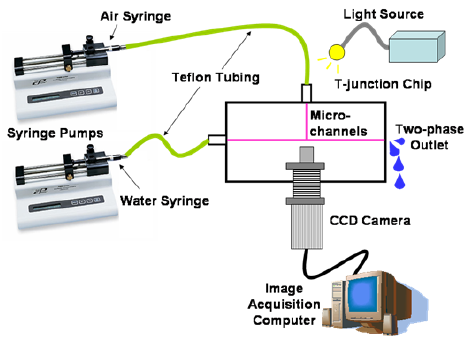
Figure 1. Experimental